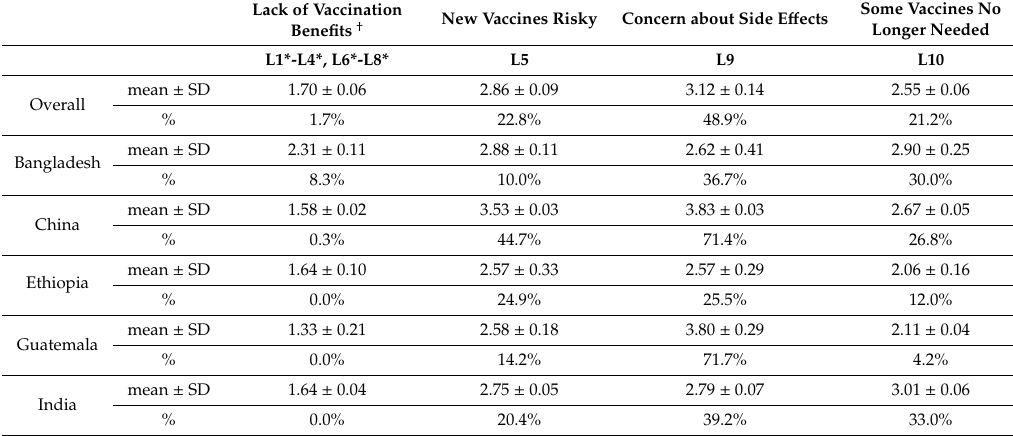
Table 4. Overall vaccine hesitancy score, and proportion of mothers who agree, stratified by construct, across the five surveyed